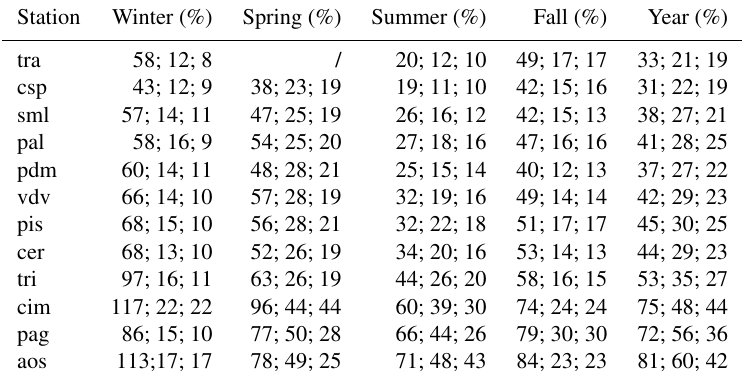
Table 5. rRMSE (%) for the RAMS-GHI 1-day forecast computed for hourly and daily integrated GHI for different seasons and stations. The first number in each cell is the rRMSE computed using hourly data, the second number is the rRMSE computed for daily integrated GHI, and the third number is the rRMSE computed after the MOS correction for daily integrated GHI (see text for